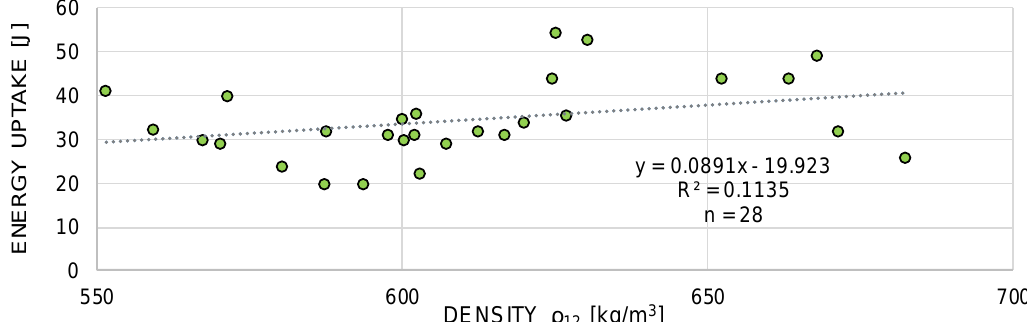
Figure 15. Correlation between energy absorption and density of the solid birch wood samples tested under standardized climate conditions.